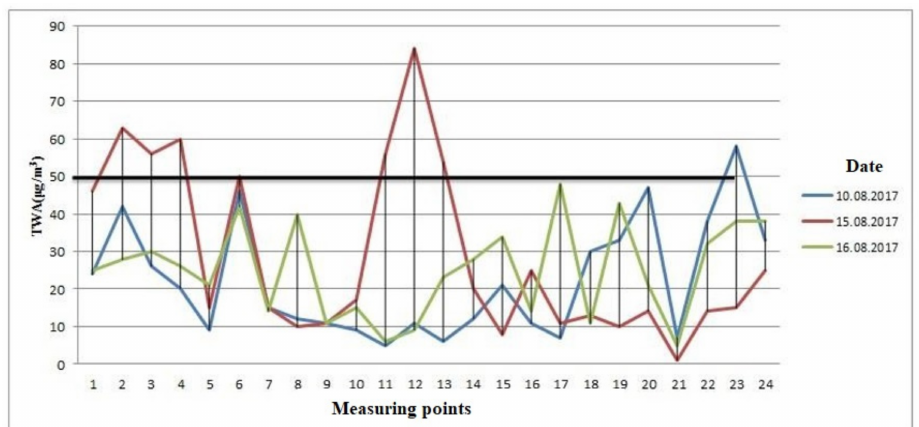
Figure 8. PM 10 Maximum Distribution Throughout.